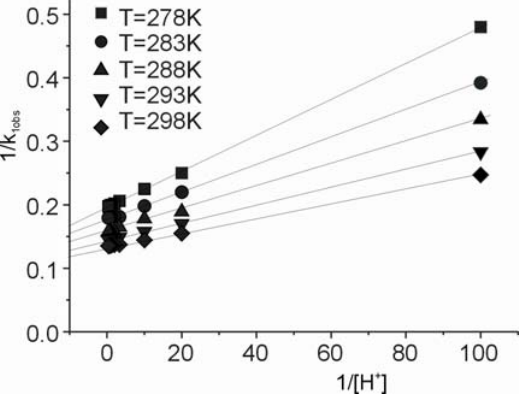
versus 1/[H + ] for the hydrolysis of 1obs